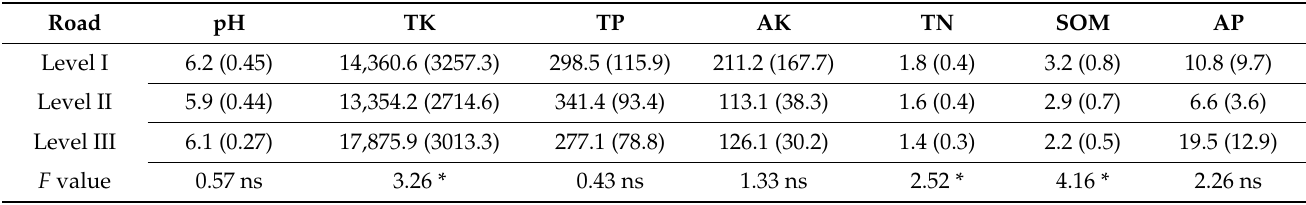
Table 2. Comparison of soil properties near different road levels.